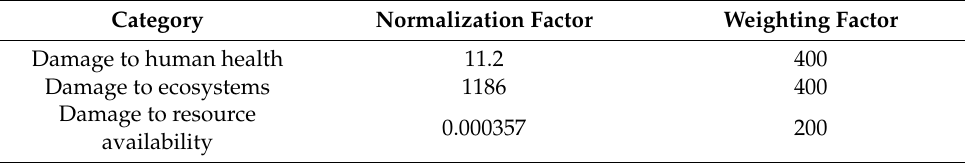
Table A6. Normalization and weighting factors for ReCiPe 2016 impact